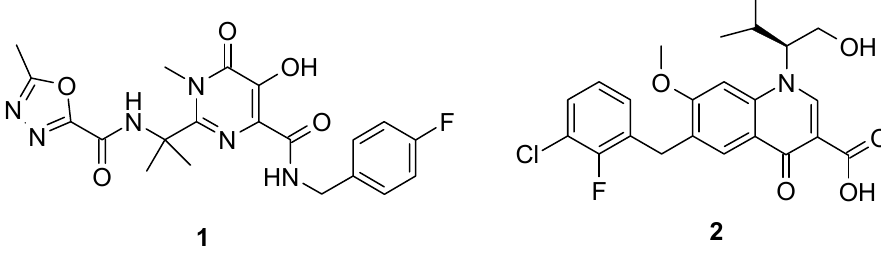
Figure 1. Chemical structures of INSTIs: Raltegravir ( 1 ) and elvitegravir ( 2